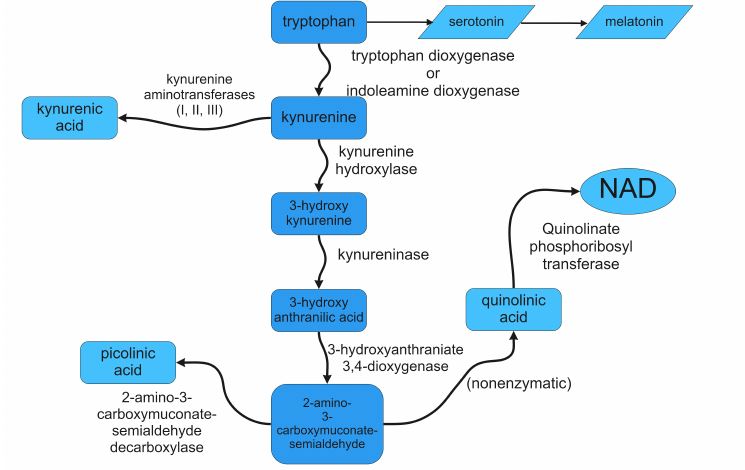
Figure 2. The kynurenine pathway of